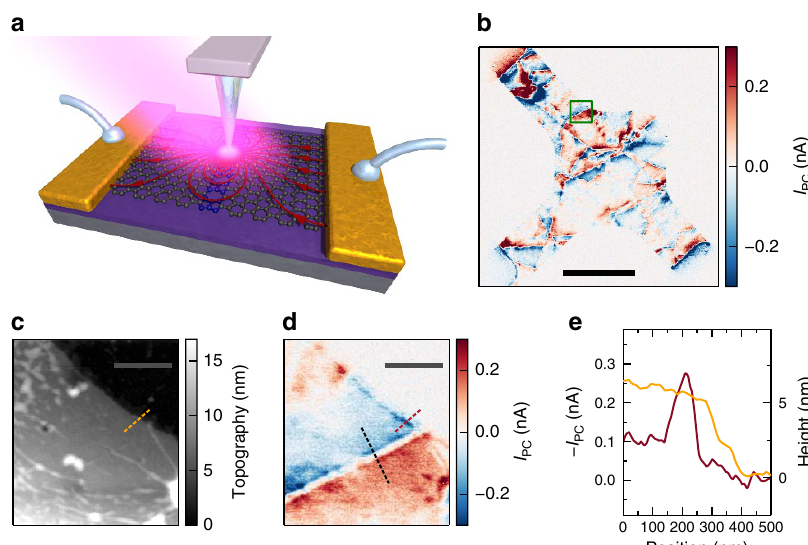
Figure 1 | Near-field photocurrent working principle and photocurrent from grain boundaries. ( a ) Sketch of the scattering-type scanning near-field optical microscope setup. A mid-infrared laser illuminates the atomic force microscope tip, which generates a locally concentrated optical field, which is absorbed by the graphene generating a position dependent photocurrent. The blue region in the graphene lattice represents a grain boundary with a modified Seebeck coefficient. The arrows sketch the photocurrent flow pattern. For each position only the magnitude and direction of the current are measured. The sketch is not to scale. ( b ) I PC map at at backgate voltage V BG ¼ 0Vof a single layer CVD graphene device (Supplementary Fig. 1) with three contacts: top left (drain), right (source) and bottom left (ground). Both grain boundaries and wrinkles show characteristic photocurrent patterns. (scale bar, 5 m m) The green box indicates the measurement region in c , d . ( c ) Topography of etched CVD graphene does not show grain boundary but only wrinkles and other inhomogeneities due to the transfer process. (scale bar, 500nm) ( d ) I PC at V BG ¼ 0V clearly shows a grain boundary and the expected sign change around it. The black dashed line indicates the measurement positions in Fig. 2a,d. (scale bar, 500nm) ( e ) Topography (orange) and I PC (red) measured at the orange line in c and the red line in d ,